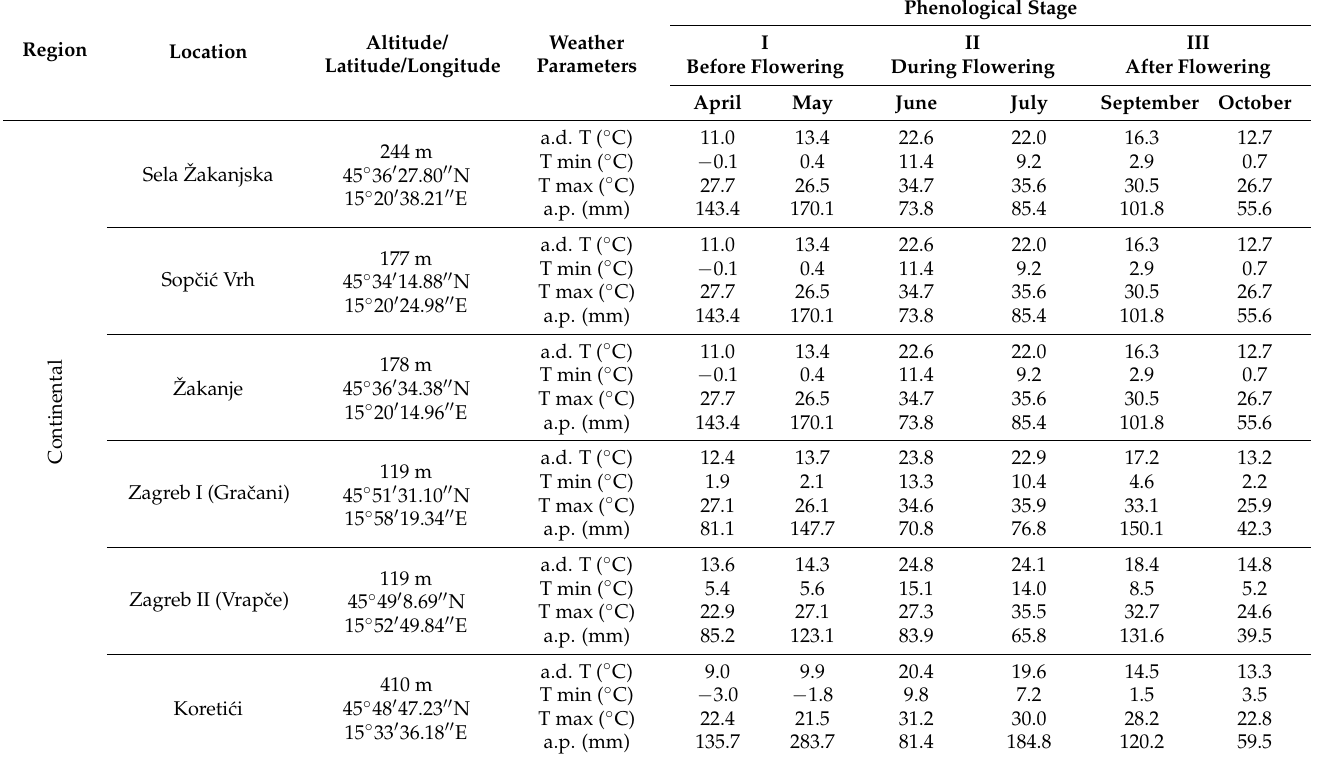
Region Location Altitude/